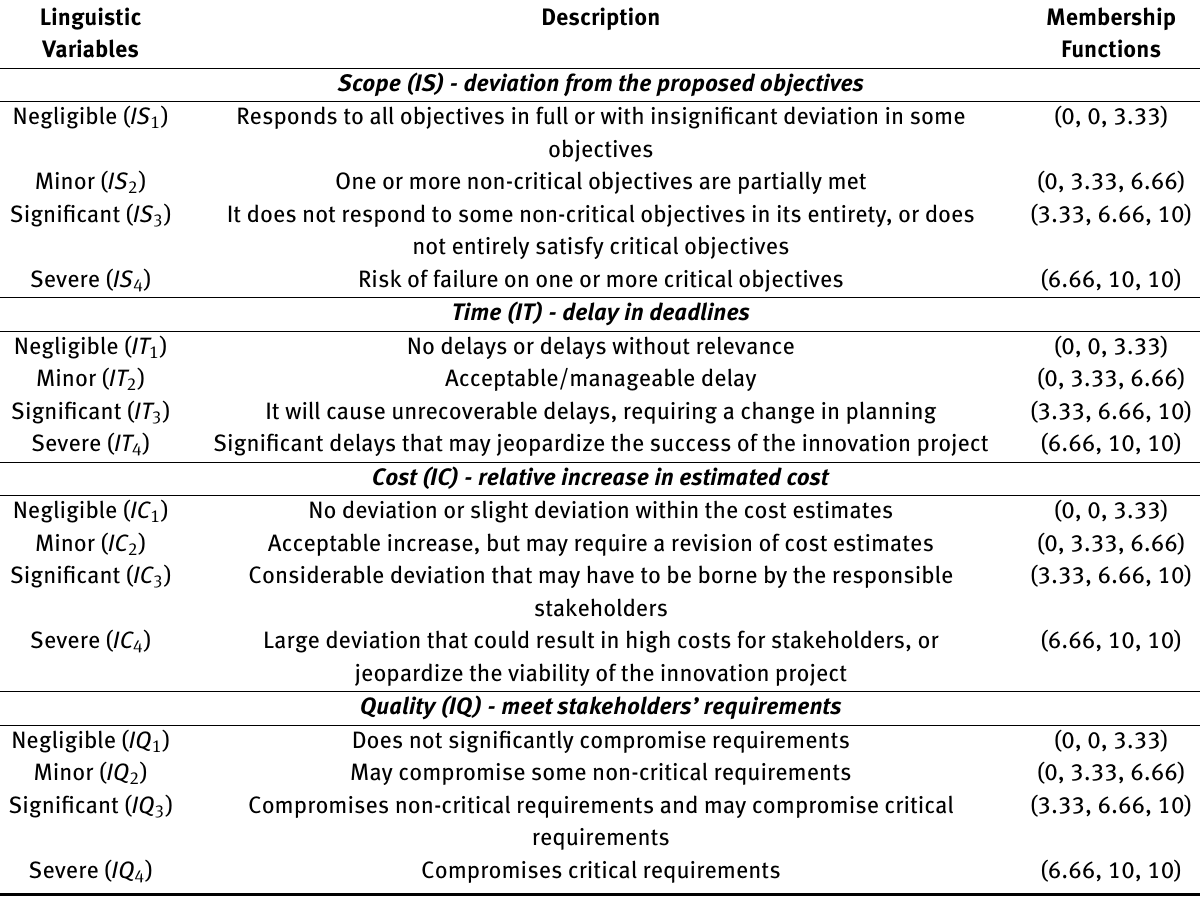
Table 2: Linguistic Variables by Impact ( I ) Category and Membership Functions. Linguistic Variables